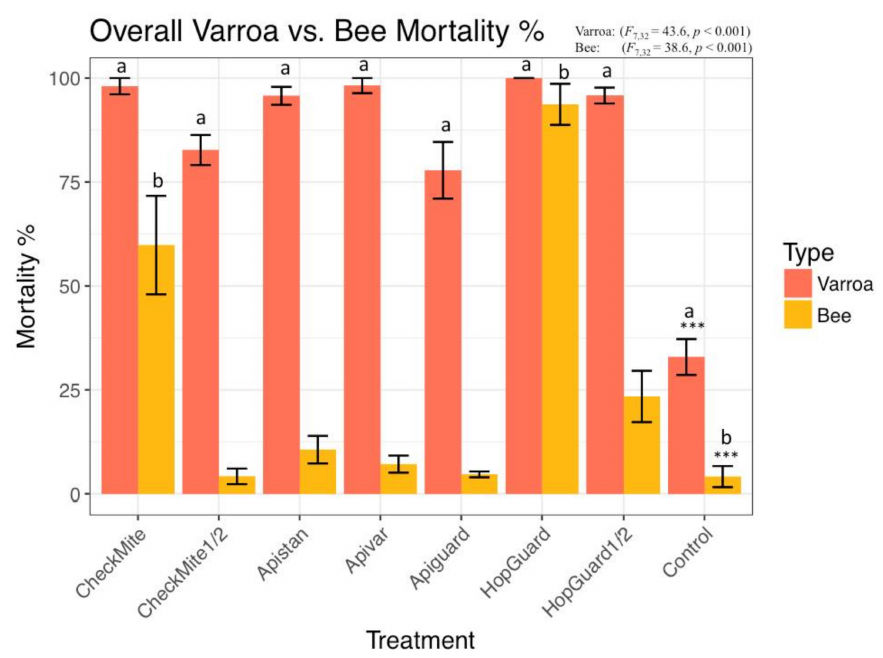
Figure 4. Total mortality for Varroa mites and their caged host bees after 48 h of exposure to 1 dose of CheckMite ® , 1 ⁄ 2 dose of CheckMite ® , Apistan ® , Apivar ® , Apiguard ® , 1 dose of HopGuard ® , 1 ⁄ 2 dose of HopGuard ® , and no acaricide (control group). Same letters indicate significant differences between a treatment and control at α = 0.05. The only significant differences that were detected occurred at p < 0.001 (***). Bars denote mean bee and mite mortality (%) ± 1 standard error